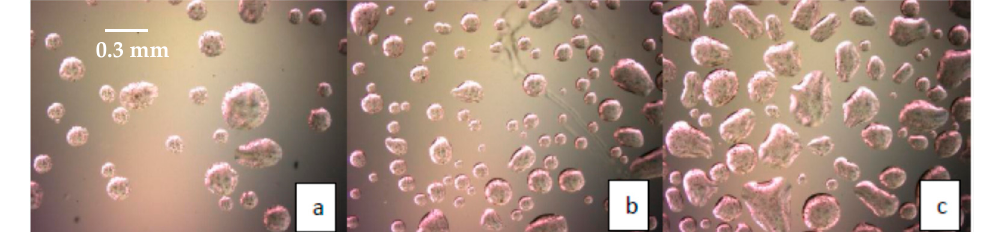
Figure 3. Pictures of droplets at triolein flow rates of ( a ) 2.5 mL/min, ( b ) 6 mL/min, and ( c ) 9 mL/min.